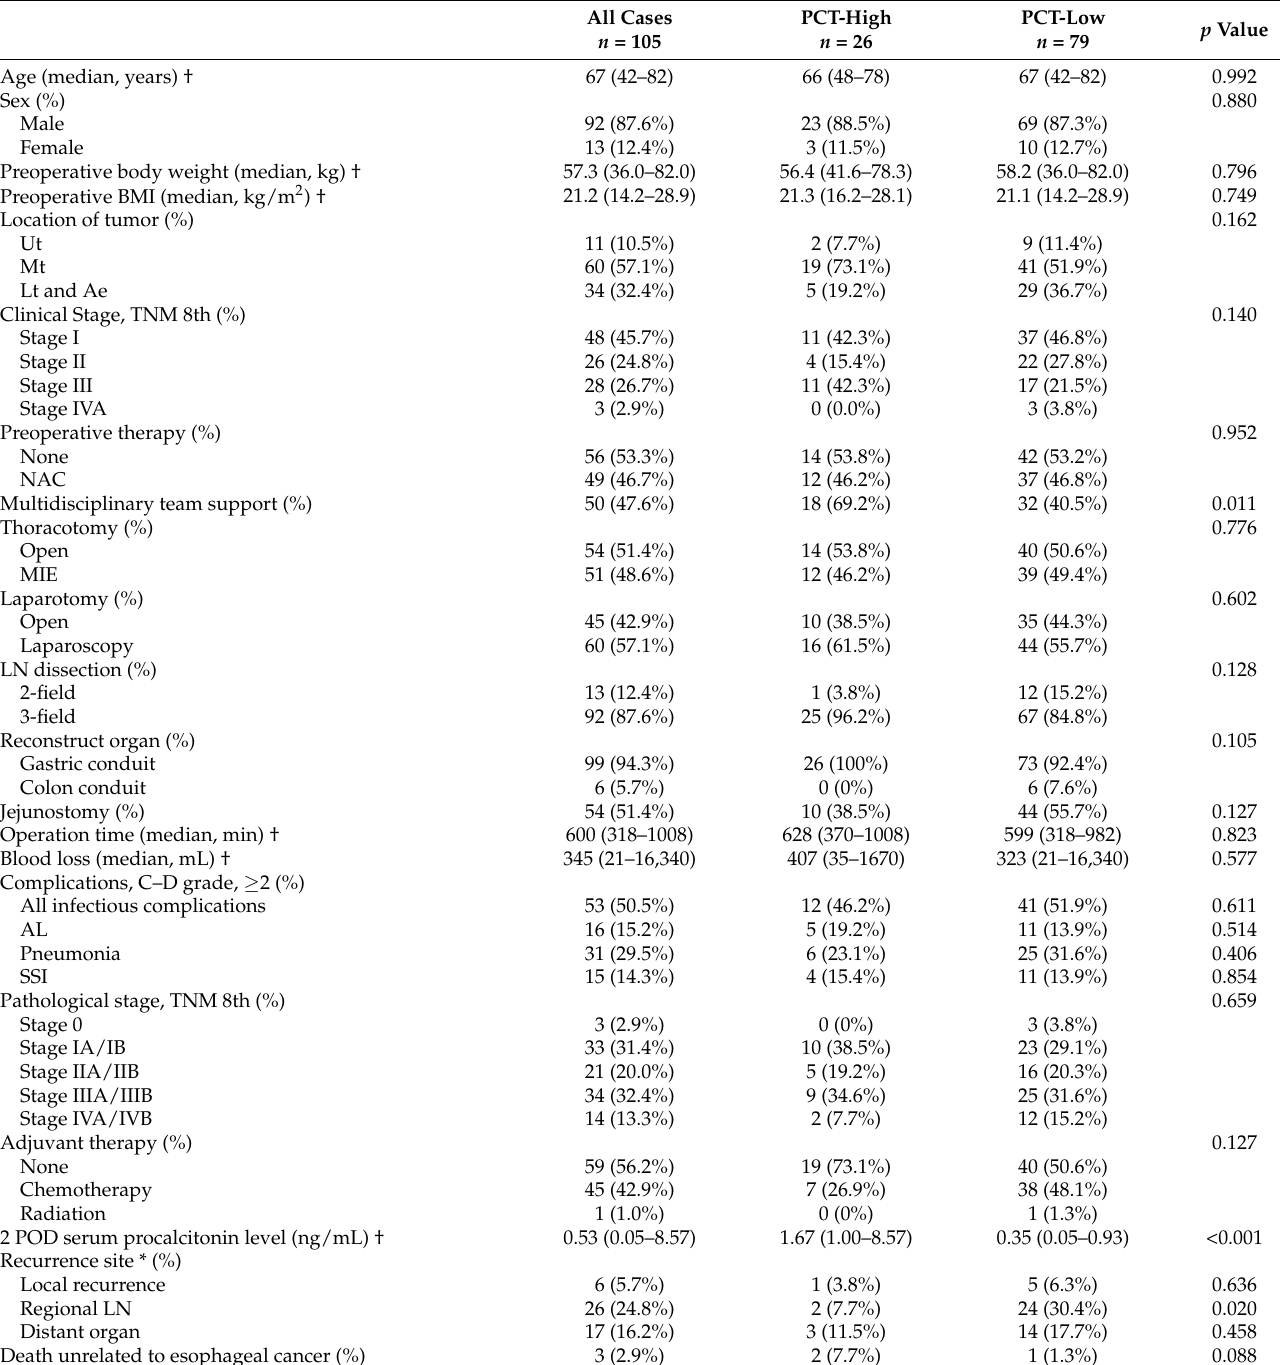
Table 1. Clinicopathological characteristics between PCT-High and PCT-Low at 2